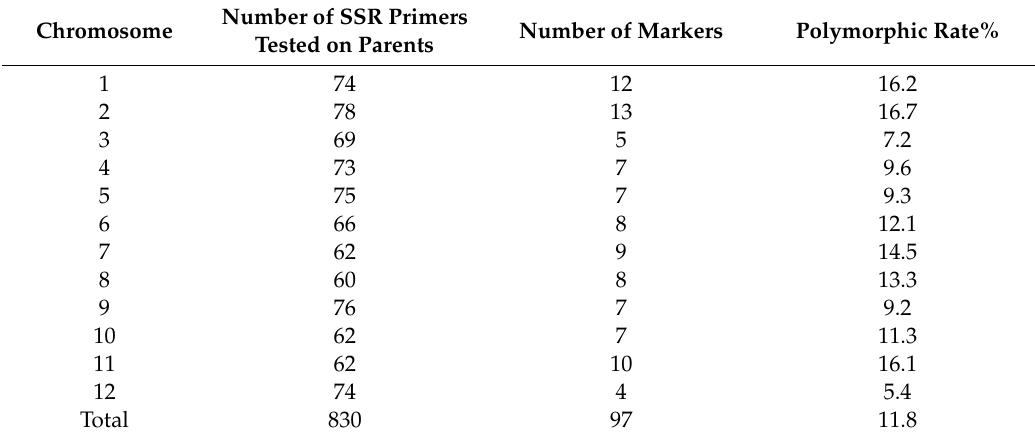
Table 1. Distribution of tested and polymorphic SSR markers on 12 chromosomes of rice.